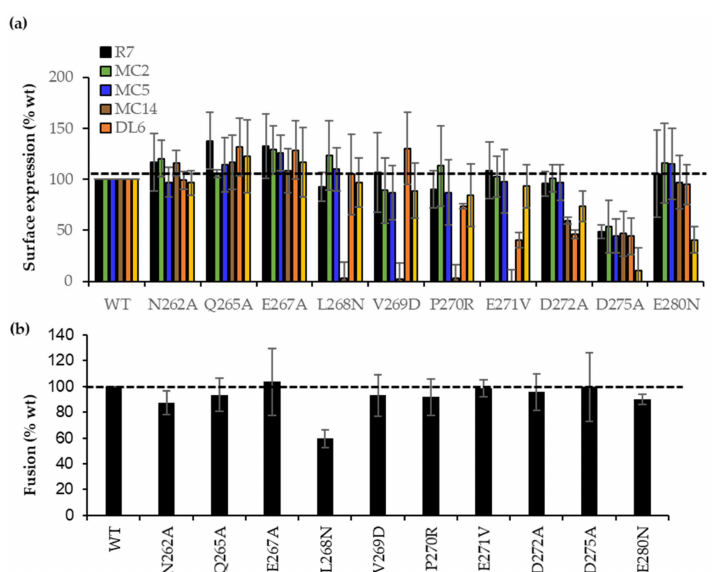
Figure 5. Characterization of point mutations in region 262–280 of full-length gD. ( a ) CELISA. Detec- tion of the surface-expressed wt and point gD mutations with sentinel Mabs from each community. Data normalized to wt with each Mab (dotted line). Average of three experiments, each done in duplicate. ( b ) Fusion function of full-length wt and mutant gDs when combined with gB, gH, and gL constructs. Data normalized to wt gD (dotted line). Average of three independent experiments, each in